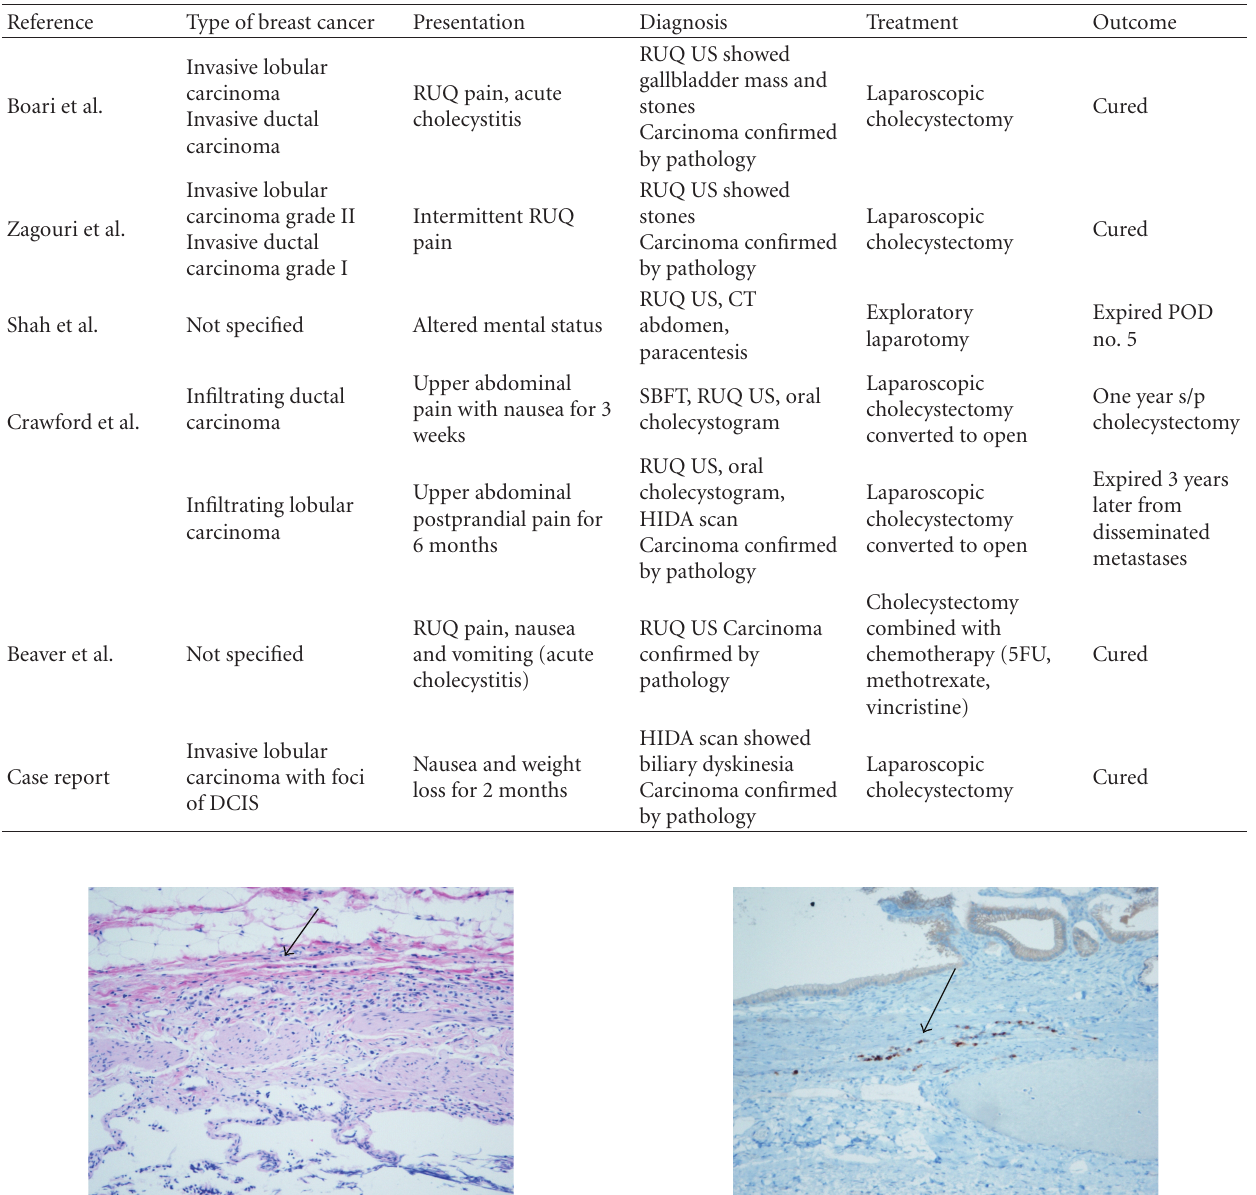
Table 1: Feature of cases with metastases of breast carcinoma to gallbladder.